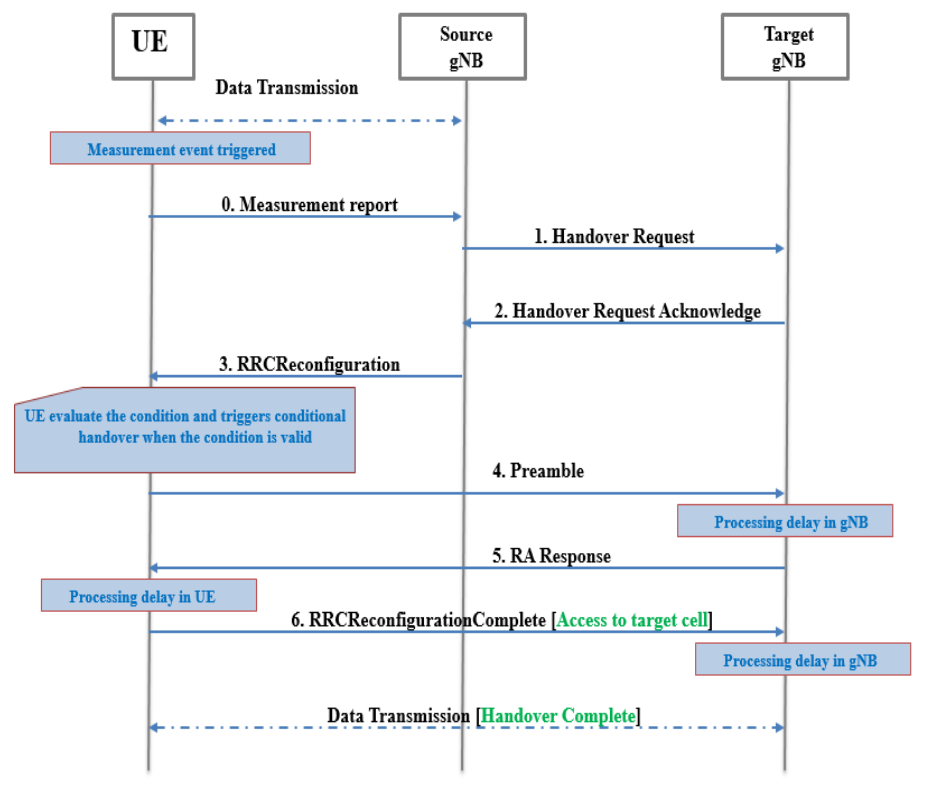
Figure 2. Procedure for Conditional